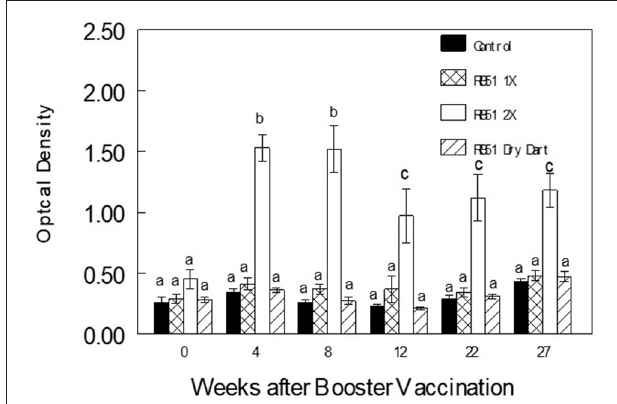
FIGURE 1 | Serologic responses of bison to γ -irradiated B. abortus strain RB51 (RB51) in an ELISA assay in non-vaccinated (Control) or after vaccination with 10 10 CFU of RB51 parenterally (RB51 1X) or in a novel dry dart formulation (RB51 Dry Dart). Responses are presented as mean titer ± SEM. Means with different superscripts are significantly different ( P < 0.05).